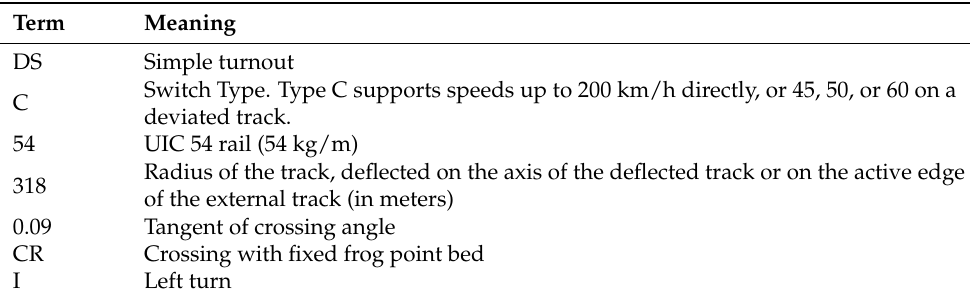
Table 1. Meaning of DS-C-54-318-0,9-CR-I TURNOUT.